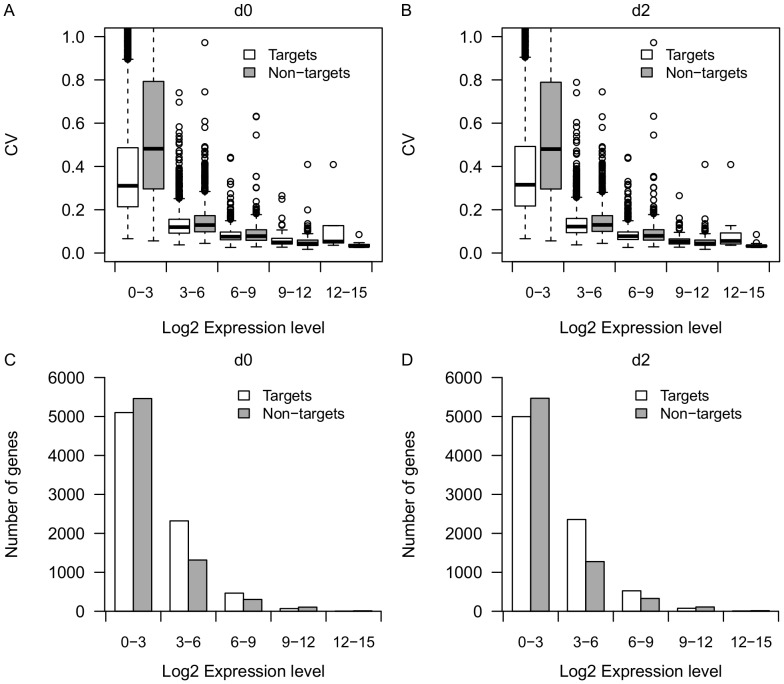
Distribution of CV and number of genes for miRNA targets and non-miRNA-targets.Boxplot of CVs for predicted targets (n = 7962) and non-miRNA-targets (n = 7211) under different expression bins (log2FPKM: 0–3, 3–6, 6–9, 9–12, 12–15) at day 0 (A) and day 2 (B). Barplot of number of genes for predicted targets and non-miRNA-targets under different expression bins (log2FPKM: 0–3, 3–6, 6–9, 9–12, 12–15) at day 0 (C) and day 2 (D).